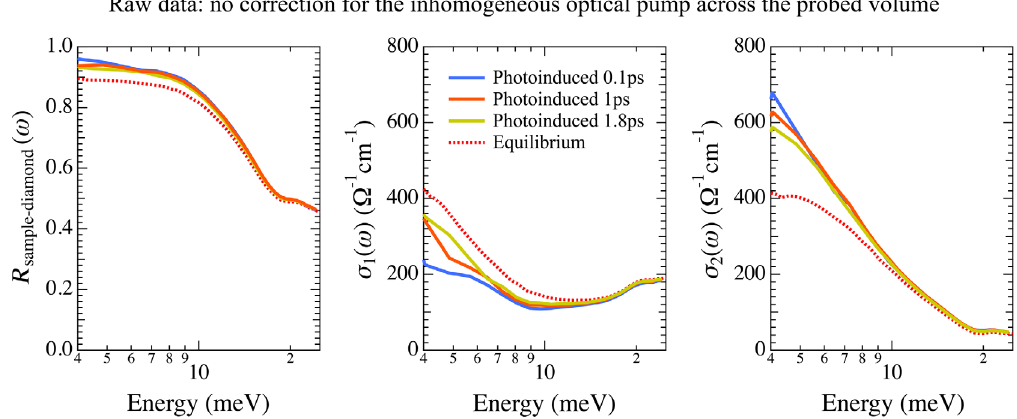
FIG. 7. The first panel shows raw data for the reflectivity (sample-diamond interface), in equilibrium and after photoexcitation by pulses of three different lengths. The second and third panels show the values of σ 1 ð ω Þ and σ 2 ð ω Þ that one would obtain from the observed reflectivity via the Fresnel equations, assuming optical conductivities independent of distance from the surface. Note that this neglects the fact that the intensity of the pump-pulse decays as a function of distance from the surface of the sample, and the probe is sampling an inhomogeneously transformed